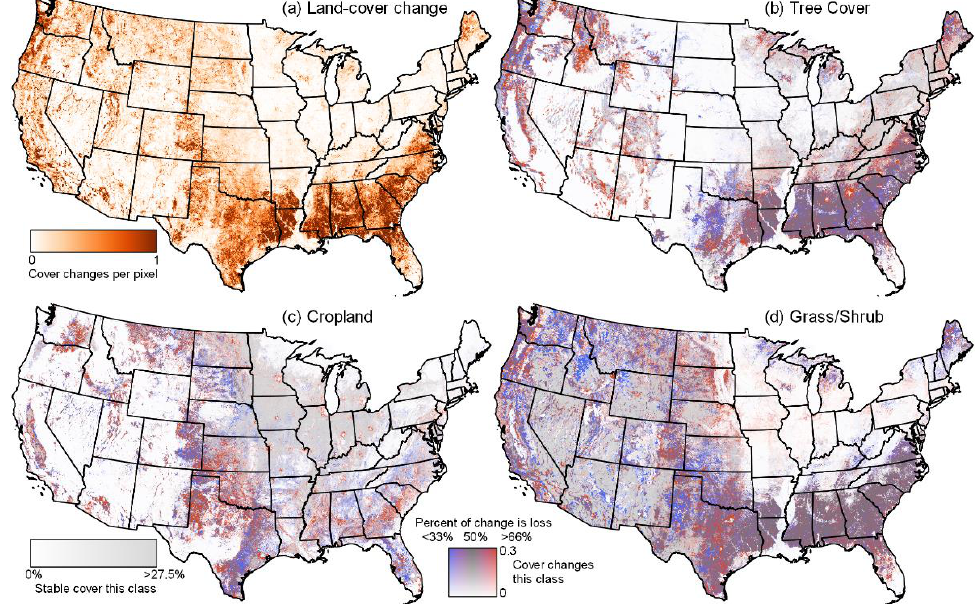
Figure 2. Land-cover conversion from 1985 to 2016. Total change is shown in ( a ) land-cover conver- sion. In the other three panels, cover change and stable cover are shown for specific classes ( b ) tree cover, ( c ) cropland, and ( d ) grass/shrub. Gray shading shows areas where stable land cover of a specific class is present. Change information is shown by a two-dimensional color scale indicating both the amount and direction of change (blue for gain, red for loss; darker shades for more change). Figure values are derived from a 3 × 3 km (100 × 100 Landsat pixel) binning of the class change map product (LCACHG, see Section 2).